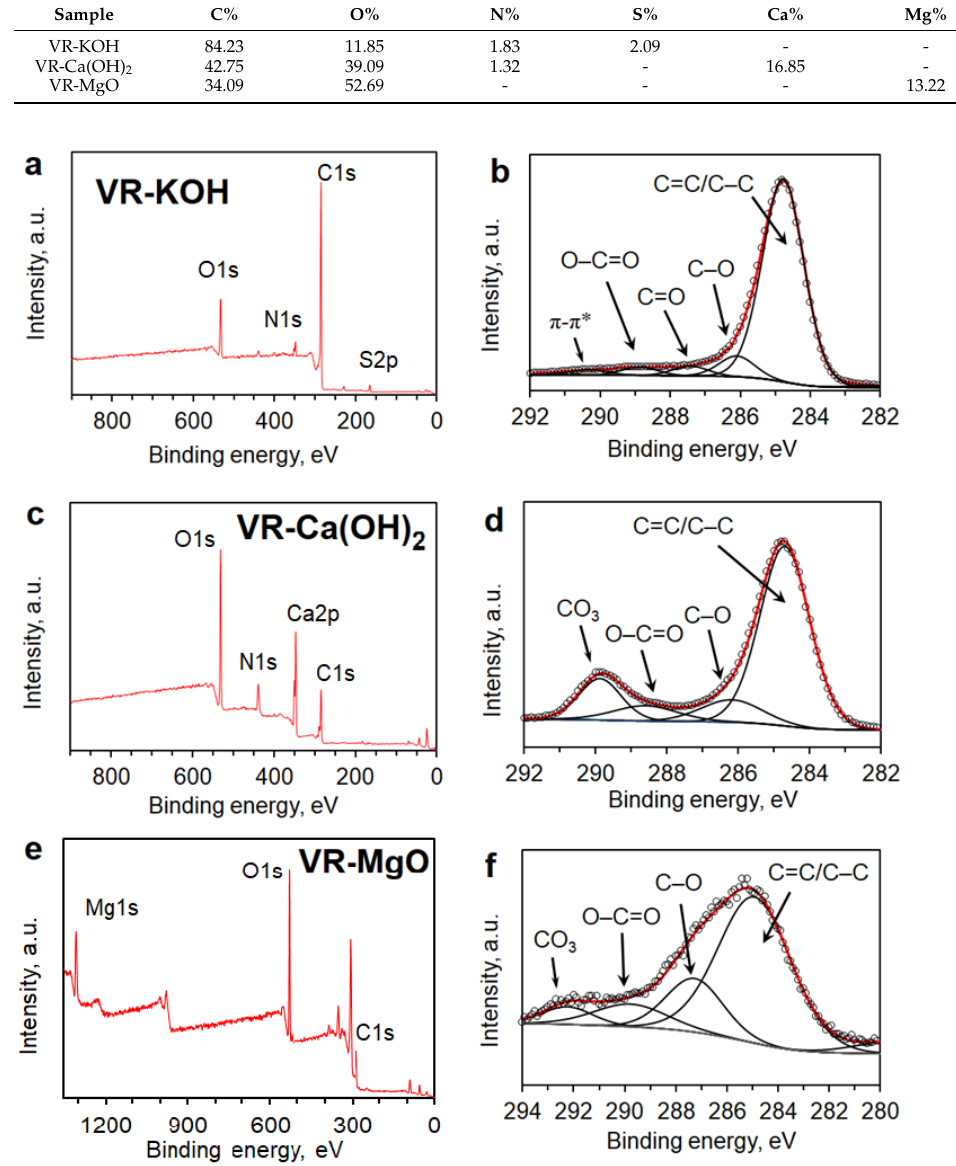
Figure 4. XPS survey spectra for ( a ) VR-KOH, ( c ) VR-Ca(OH) 2 , and ( e ) VR-MgO. XPS high-resolution C 1s spectra for ( b ) VR-KOH, ( d ) VR-Ca(OH) 2 , and ( f ) VR-MgO.